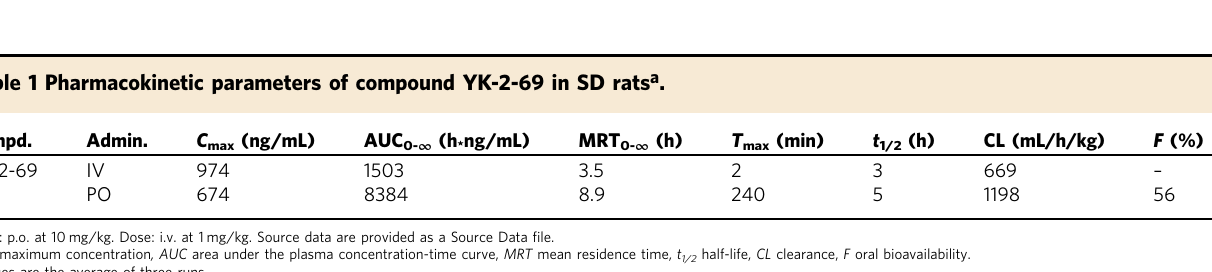
Fig. 6 Transcriptome-wide RNA sequencing assays in PCa DU145 cells. a Transcriptome strategy of RNA-sequencing conducted on DU145 cells exposed to YK-2-69 (3 µ M) for 48 h. The shNC, shDYRK2, DMSO, and YK-2-69 groups all contain two biological replicates. Venn diagram of upregulated and downregulated signaling pathways in DYRK2 KD- and YK-2-69-treated DU145 cells. The number of genes in every signaling pathway is >50. Normalized enrichment score (NES) >1 or < − 1; P < 0.05; FDR < 0.25. b The signaling pathways enriched in different groups obtained through Gene Set Enrichment Analysis (GSEA). c The core-enriched decreased (blue) and increased (red) signaling pathways in shDYRK2 and YK-2-69 treatment groups when compared with shNC and DMSO groups, respectively. The signaling pathways with P < 0.05 are presented. d The relative abundance of genes involved in MYC target V1, MYC target V2 and Mitotic SPINDLE in DYRK2 KD- and YK-2-69-treated DU145 cells. n = 2. The whiskers of boxplot represent the quantile percentile, from bottom to top are minima, 25%, median, 75%, and maxima respectively. Two-tailed Student ’ s t test was applied without adjustment for multiple comparisons (FDR). e GSEA was used to analyze the effects of DYRK2 KD or YK-2-69 treatment on the ANDROGEN RESPONSE signaling pathway in DU145 cells. f Volcano plot of signi fi cantly affected genes (absolute fold change > 2, P < 0.05) in DU-145 shDYRK2 group relative to shNC group and YK-2-69 group relative to DMSO group. The negative binomial distribution test of DESeq2 software was used. g Effects of DYRK2 KD or YK-2-69 treatment on the RRS1 , GRWD1 , CCNG2 , and YPEL3 mRNA levels in DU145 cells. Unpaired two-tailed Student ’ s t test. Error bar, mean ± SD, n = 3. h The principal component analysis was used to identify transcriptome differences between two samples. i The different signaling pathways enriched in DYRK2 KD and YK-2-69 treatment groups obtained through GSEA. Source data are provided as a Source Data fi le.